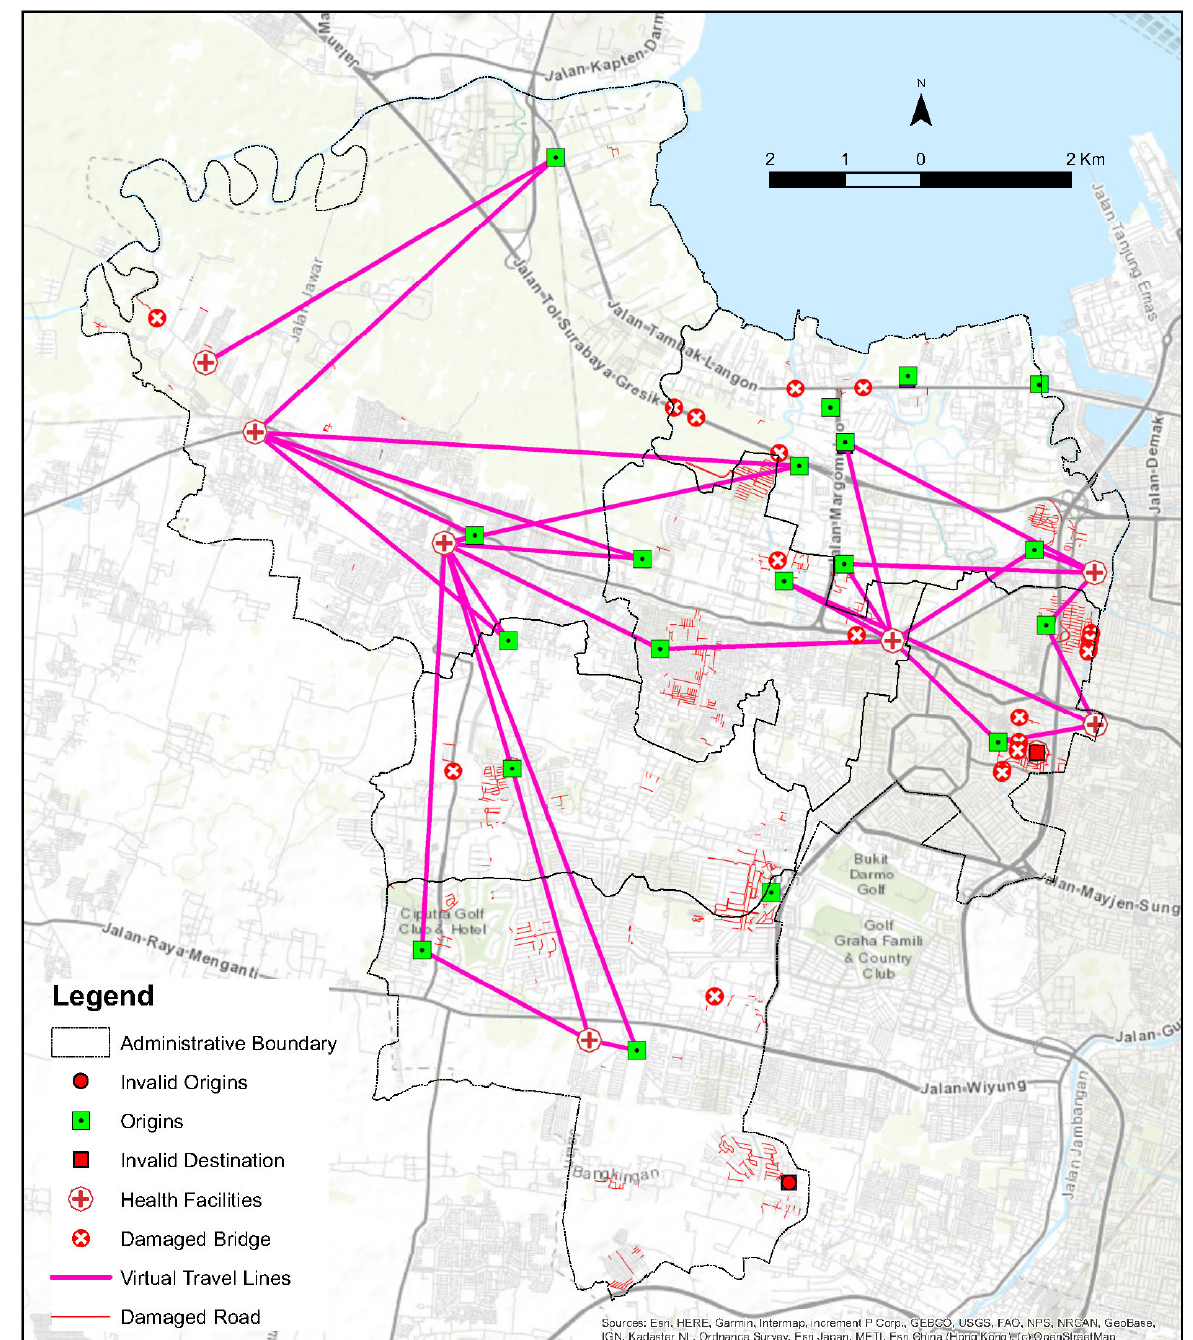
Figure 12. Route analysis after flood.